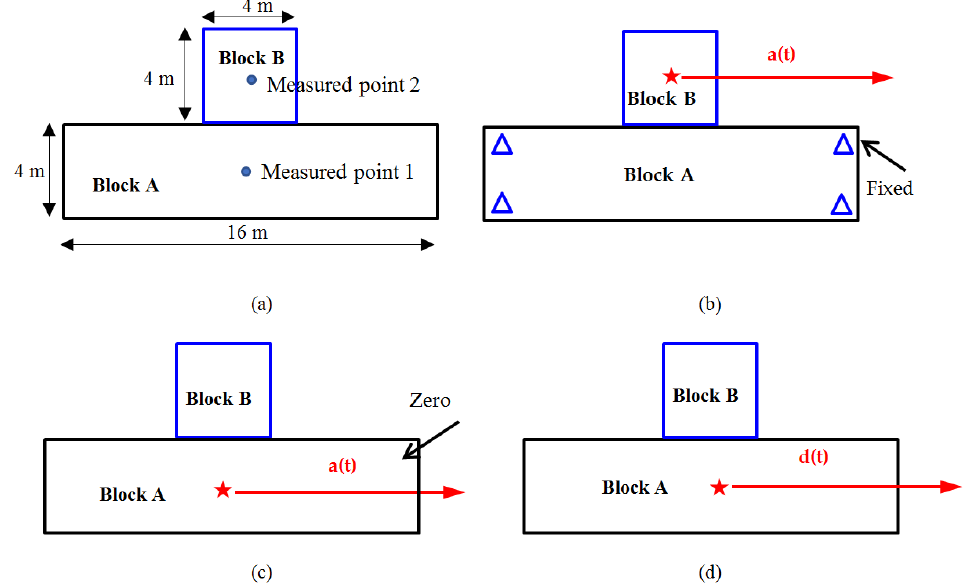
Figure 5. Seismic input methods of DDA: ( a ) block geometry; ( b ) multi-blocks Newmark method; ( c ) large mass method; ( d ) large stiffness method.